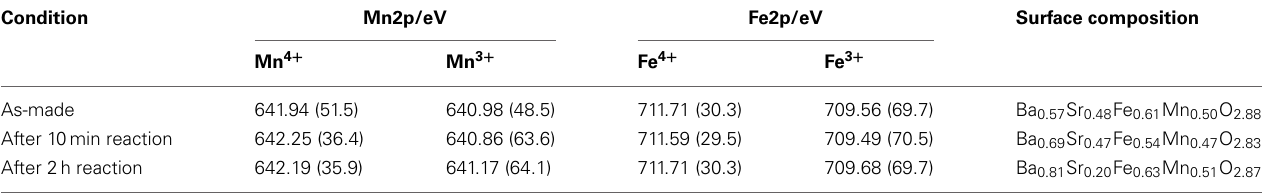
Table 6 | Binding energy and surface lattice vacancy of Ba 0 . 4 Sr 0 . 6 Fe 0 . 6 Mn 0 . 4 O 3 − δ catalyst under various reaction conditions.